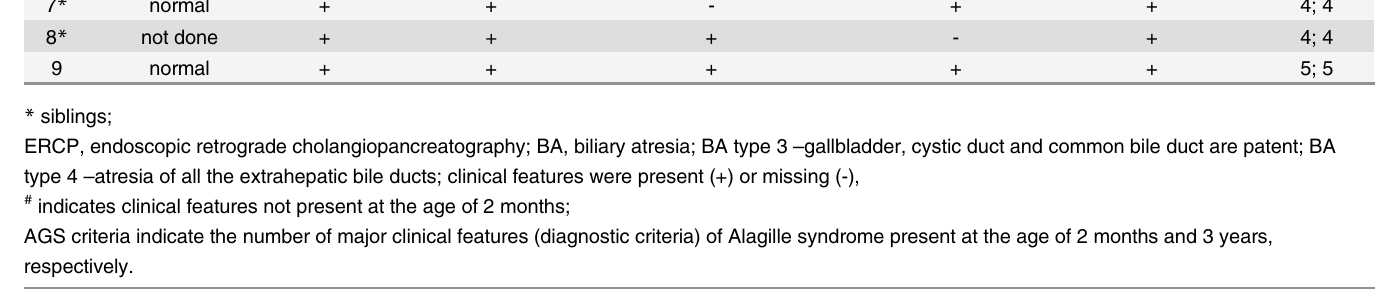
type 4 – atresia of all the extrahepatic bile ducts; clinical features were present (+) or missing (-), # indicates clinical features not present at the age of 2 months; AGS criteria indicate the number of major clinical features (diagnostic criteria) of Alagille syndrome present at the age of 2 months and 3 years,